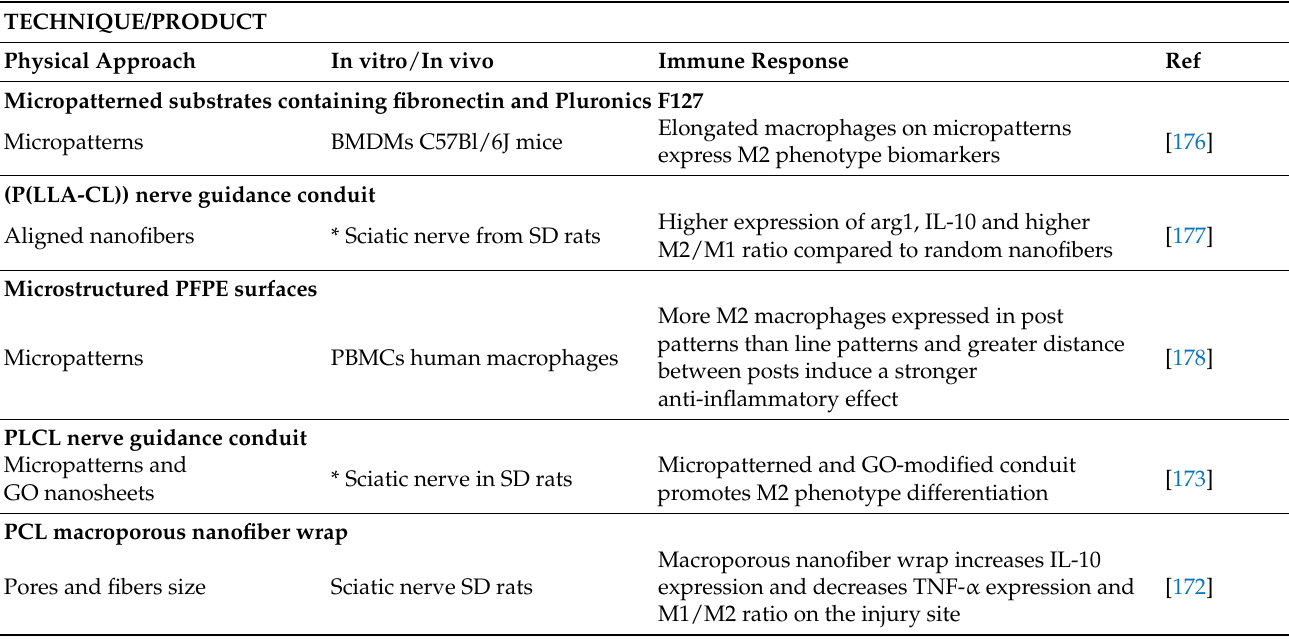
Table 1. Physical modifications for the polarization of macrophages during